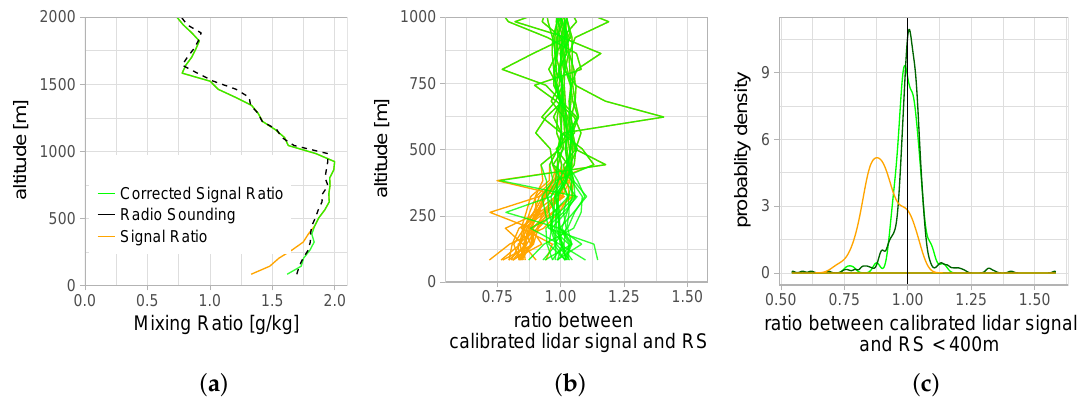
Figure 5. ( a ) Exemplary lidar profile used for calibration (20 February 2018); ( b ) ratio between the calibrated lidar signal and radiosounding measurement, with (green) and without (orange) overlap correction for all profiles with parallel measurements in 2018; and ( c ) probability density function (PDF) of ratio between radiosounding and the uncorrected (orange) and corrected (green) lidar signal in the lowermost 400m. The ratio between the signals in the altitudes chosen for calibration is shown as a reference (dark